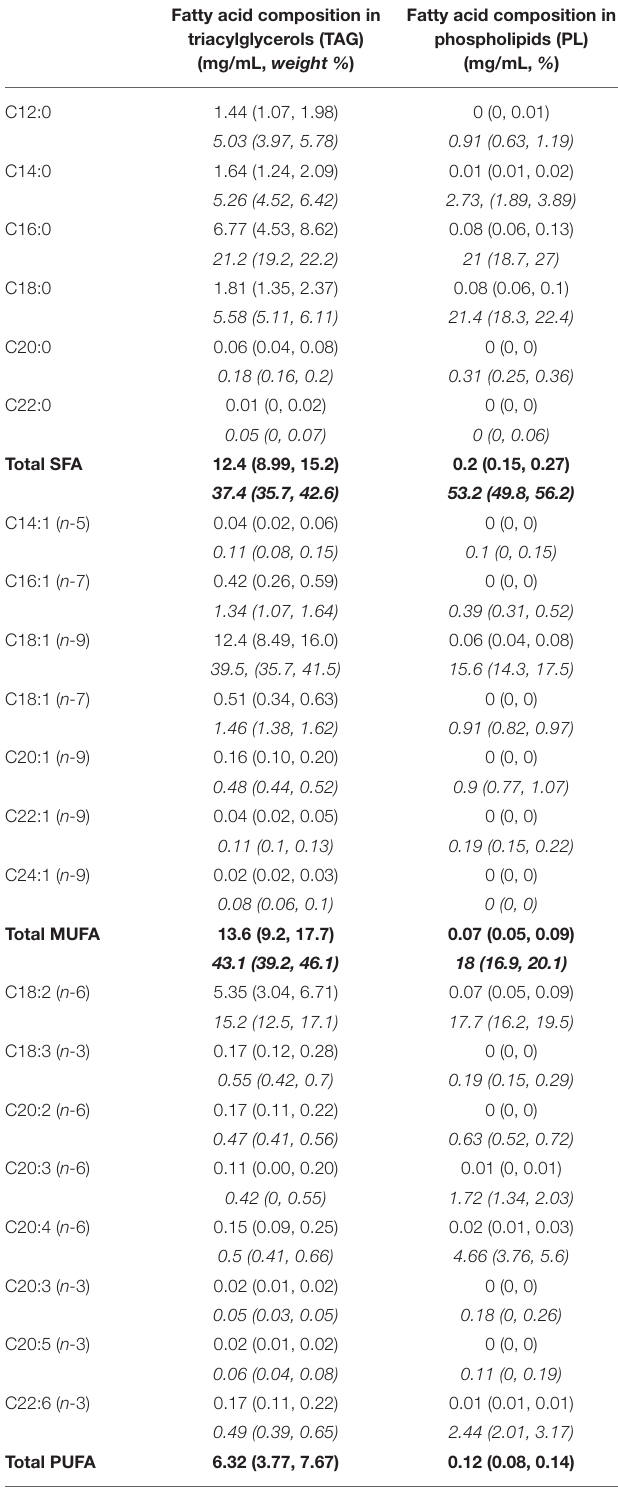
TABLE 3 | Fatty acid (FA) composition in triacylglycerol and phospholipid rich-fractions in median (1st Q and 3rd Q) quantification (mg/ml) and weight % (in italics).